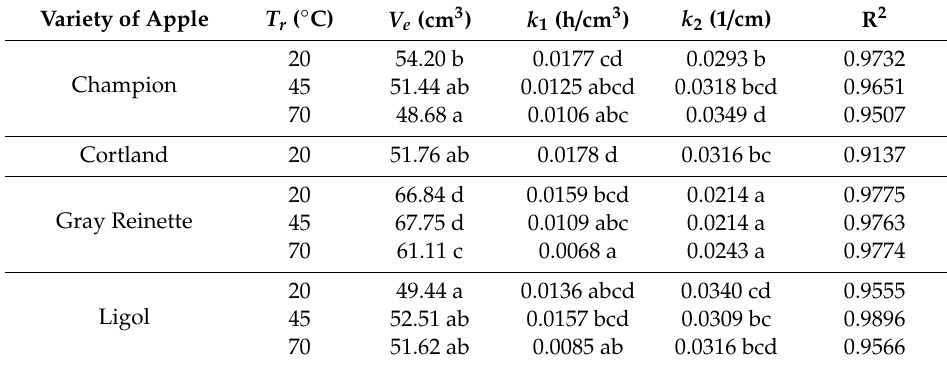
Table 4. Results of the application of the Peleg model (Equations (12) and (13)) for approximating the volume increase during the rehydration of di ff erent varieties of dried